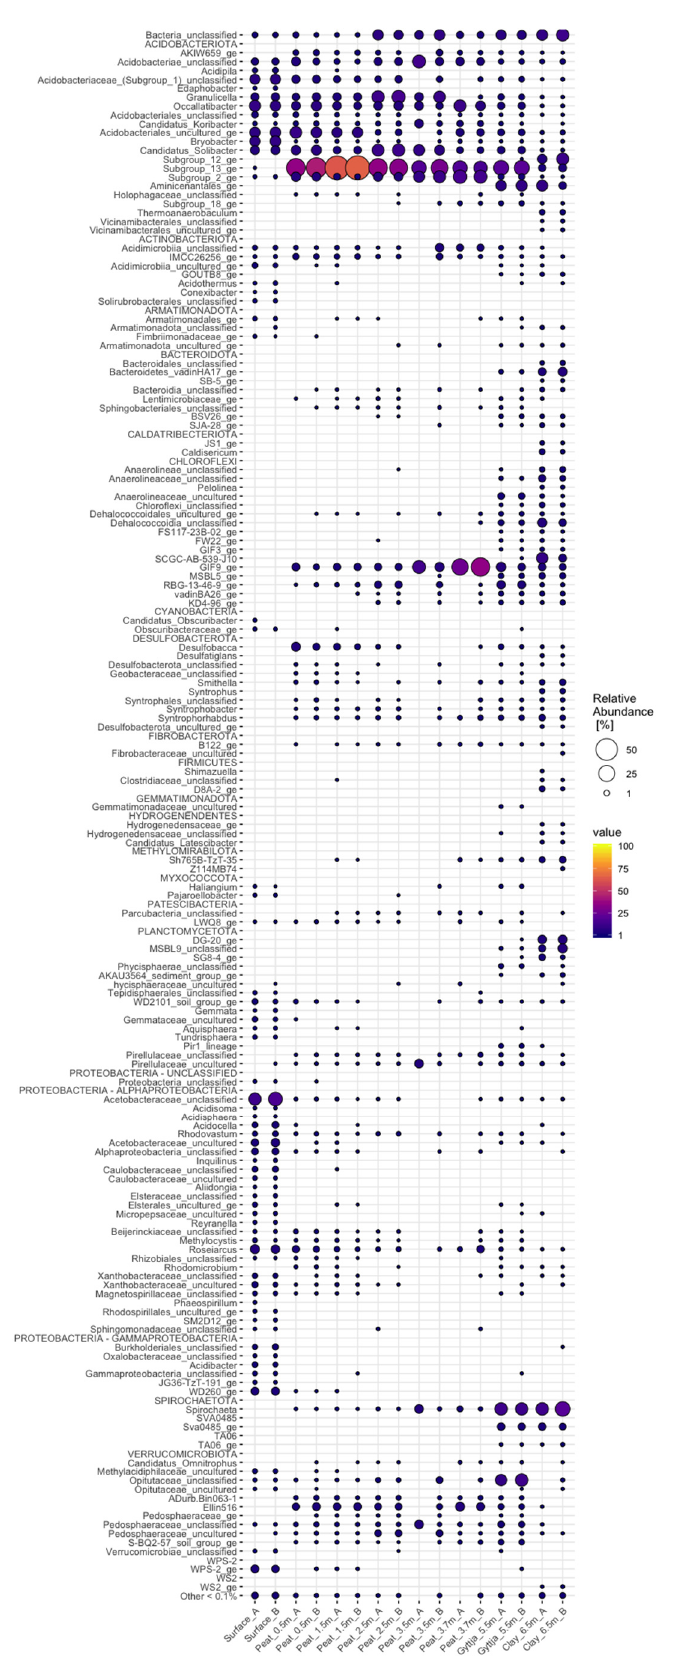
Figure A3. The relative abundance of the bacterial genera (% of sequence reads) in the Lastensuo bog samples.